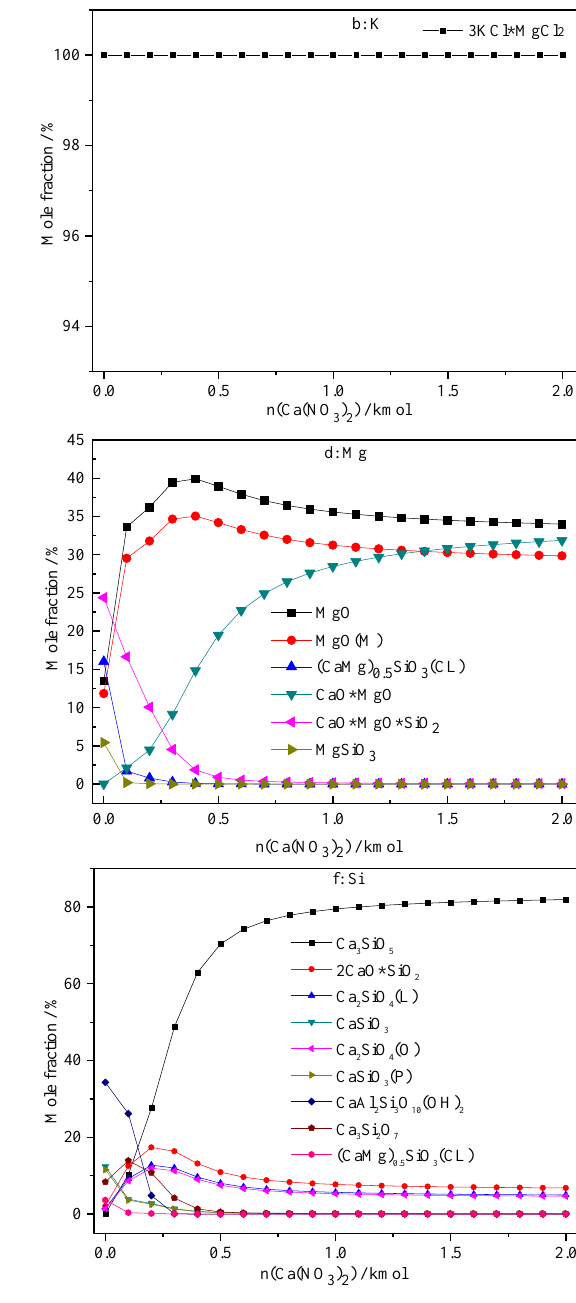
Figure 4. Effect of the amount of Ca(NO 3 ) 2 addition on the migration and transformation of main elements in ash. ( a ): Na, ( b ): K, ( c ): Ca, ( d ): Mg, ( e ): Cl, ( f ): Si. The asterisk in the chemical formula shows that the molecules or species are attached with each other as independent species, similarly hereinafter.